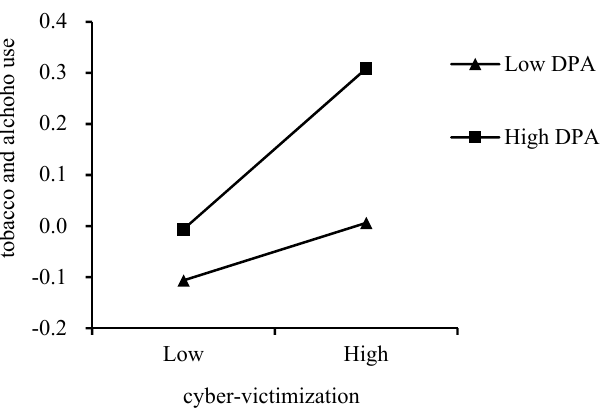
Figure 1. Moderating effect of deviant peer affiliation (DPA) on the relationship between cyber- victimization and tobacco and alcohol use among elementary school students.